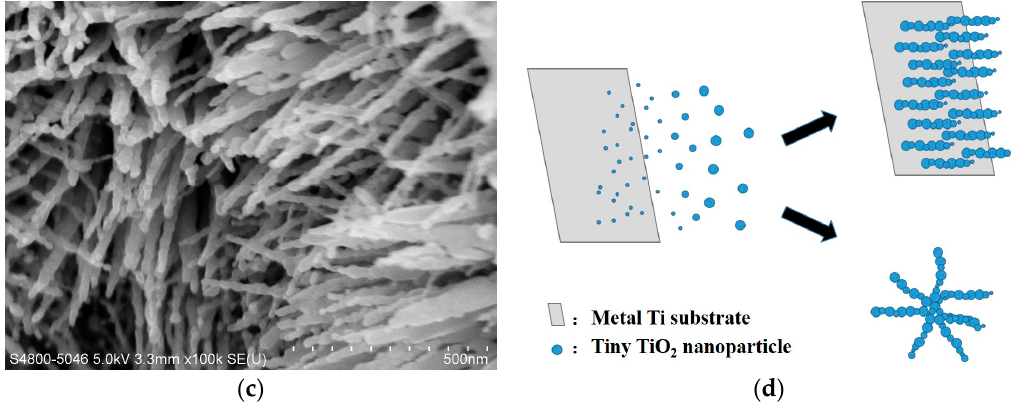
Figure 11. ( a ) SEM image of single TiO 2 nanoflower; ( b ) SEM image of TiO 2 powder collected from the post-depositional solution; ( c ) the clear SEM image of the branches of TiO 2 nanoflower; ( d ) schematic diagram of the TiO 2 deposition process.